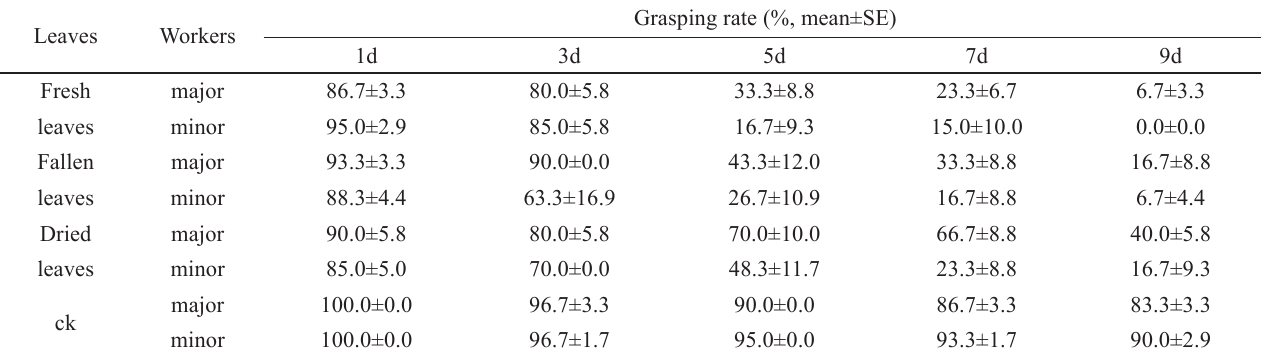
Table 3. Effects on grasping rate of workers after treated with mashed fresh, fallen, and dried leaves of M. exotica.